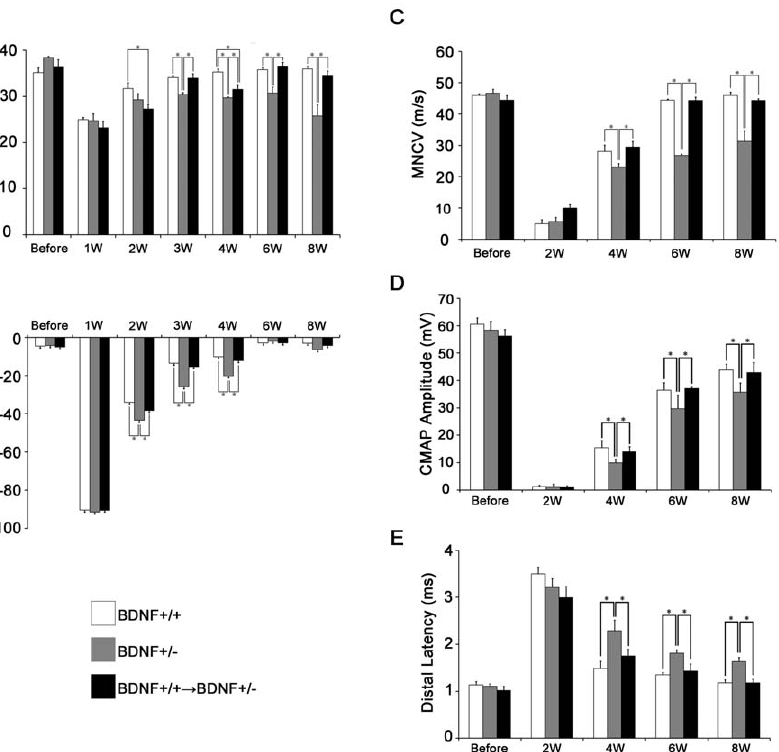
Figure 3. Functional changes of sciatic nerve in BDNF + / 2 . A ) The maximum rpm of the rotarod treadmill test were measured for littermates (BDNF + / + ), BDNF + / 2 and BDNF + / + R BDNF + / 2 (n=5 per genotype). B ) The SFI of the same groups of mice. (n=5 per each group). C ) Motor Nerve Conduction Velocity of the same groups of mice. (n=5 per each group). D ) CMAP amplitude of the same groups of mice (n=5 per each group). E ) Distal latency of the same groups of mice (n=5 per each group). Data are the mean 6 SEM. *p ,